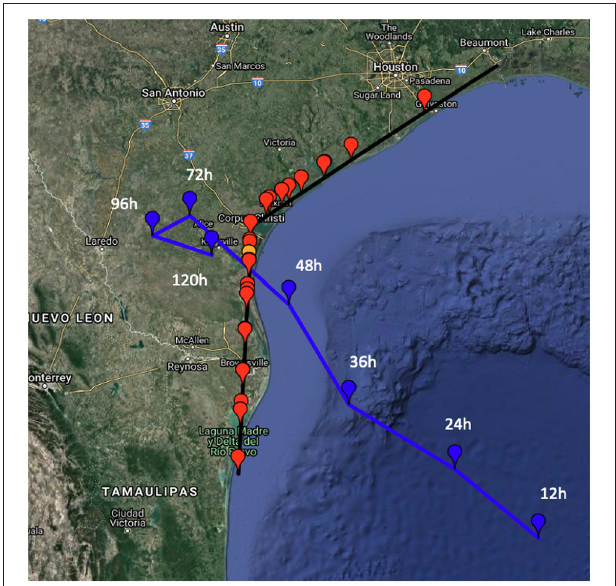
FIGURE 2 | Twenty-five simulated landfall locations for Hurricane